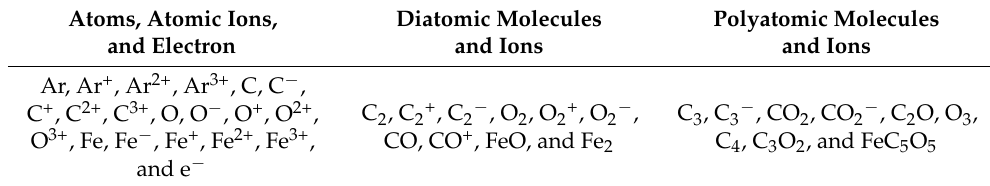
Table 1. Chemical species at equilibrium state for the [82%Ar-18%CO 2 ]-Fe plasmas. Atoms, Atomic Ions, and Electron